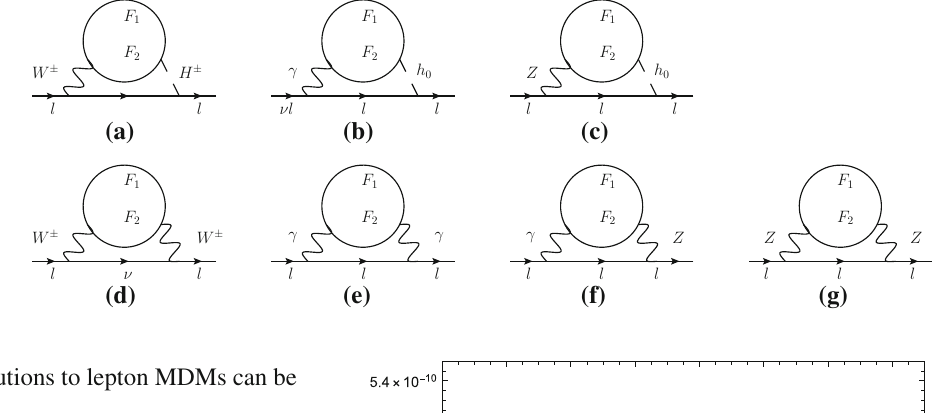
Fig. 3 The two-loop Barr-Zee